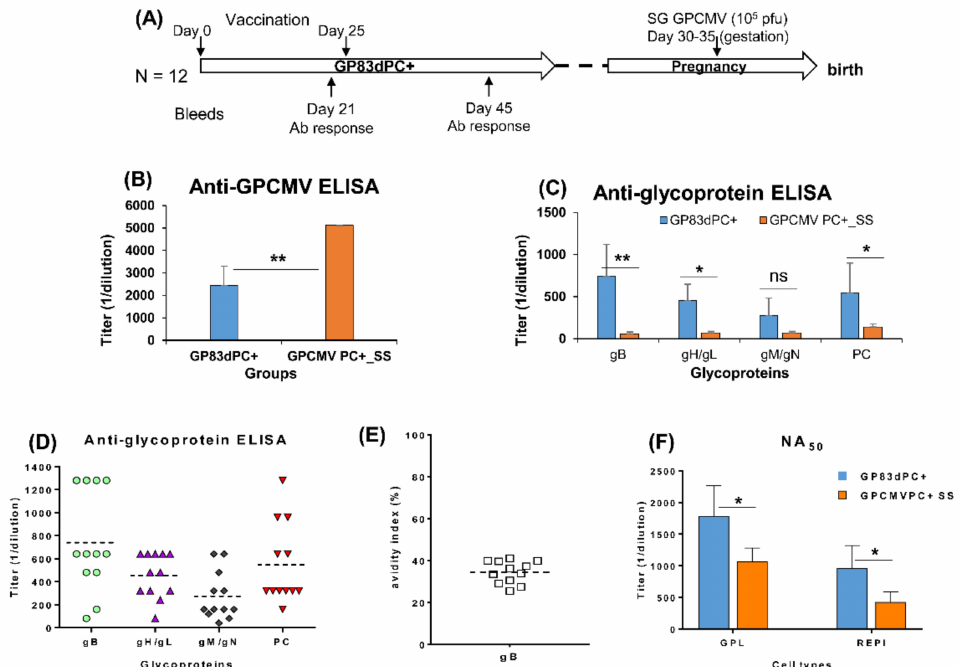
Figure 2. GP83dPC+ vaccination schedule and immune response. ( A ) Overview of GP83dPC+ preconception vaccine and challenge schedule. Animals were vaccinated 2 times (10 5 pfu) via SQ route: day 0 and 25. Serum collected 3 weeks post each vaccination (days 21 and 45). Dams were mated, and during late second trimester of pregnancy, animals were challenged with 10 5 pfu salivary gland (SG) stock wt GPCMV (SQ), then followed to term. ( B ) Mean anti-GPCMV ELISA titer from sera collected at D45 in animals inoculated with GP83dPC+ (blue) or sera from single inoculation of wtGPCMV (orange). ( C ) Mean anti-glycoprotein complex ELISA titers (gB, gH/gL, gM/gN, PC) from sera collected at D45 in animals inoculated with GP83dPC+ (blue) or sera from single inoculation of wtGPCMV (orange). ( D ) Evaluation of GP83dPC+ vaccine glycoprotein complex ELISA